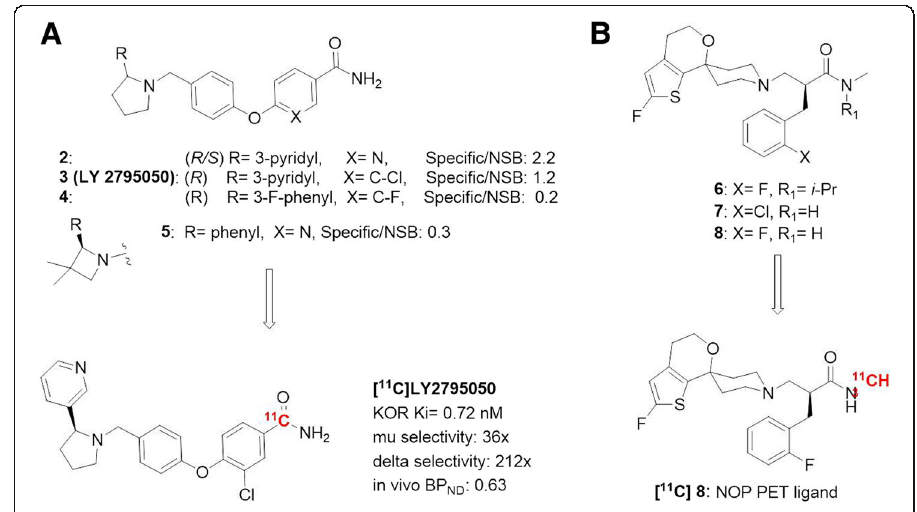
Fig. 7 Discovery of novel CNS PET ligands facilitated by the LC-MS/MS method